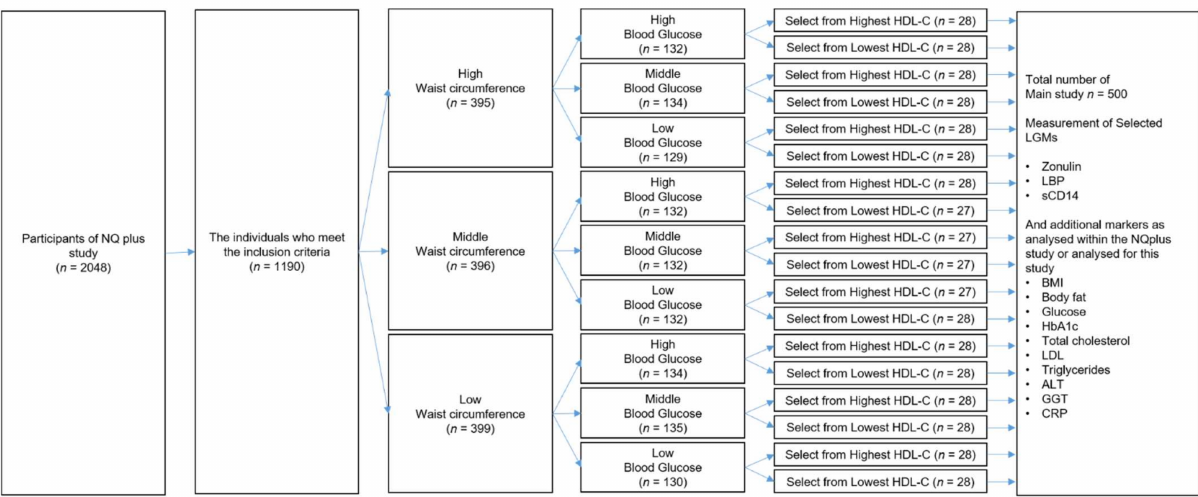
Figure 2. Schematic overview of the individuals selected from the NQplus study. Following this scheme, 500 individuals with a broad metabolic profile were selected from the NQplus study. LGM: leaky-gut marker, BMI: body mass index, HbA1c: glycated hemoglobin A1c, HDL: high-density lipoprotein, LDL: low-density lipoprotein, ALT: alanine aminotransferase, GGT: gamma-glutamyl transpeptidase, CRP: C-reactive protein, LBP: lipopolysaccharide-binding protein, and sCD14: soluble